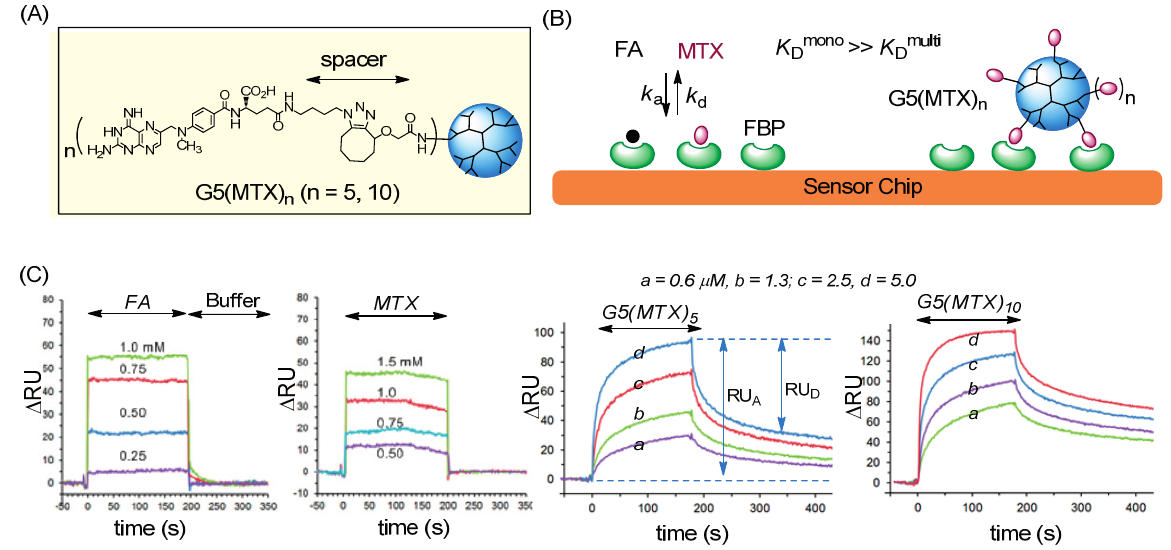
Figure 3. ( A ) Structure of G5(MTX) n ( n = 5, 10) dendrimer conjugated with MTX via cyclooctyne-azide click chemistry; ( B ) Schematic for binding of FA, MTX and G5(MTX) n to the surface of a folate binding protein (FBP)-immobilized CM5 sensor chip; ( C ) Overlaid dose-dependent SPR sensorgrams [51].